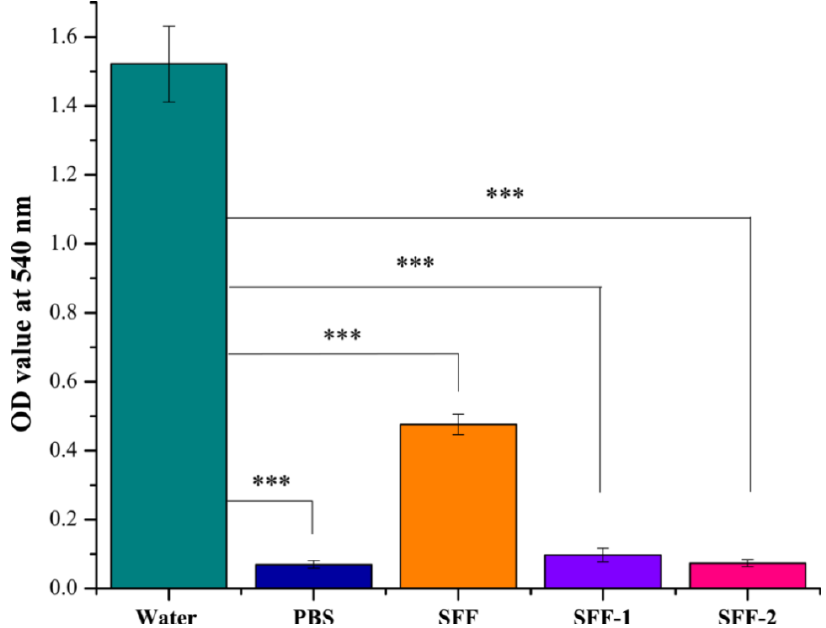
Figure 10. Mean hemolytic assay results of untreated (SFF) and modified fibroin fabric samples (SFF-1 and SFF-2) compared to exposure to the PBS solution negative control and the water positive control. Mean data for each sample ( n = 3) are presented. Error